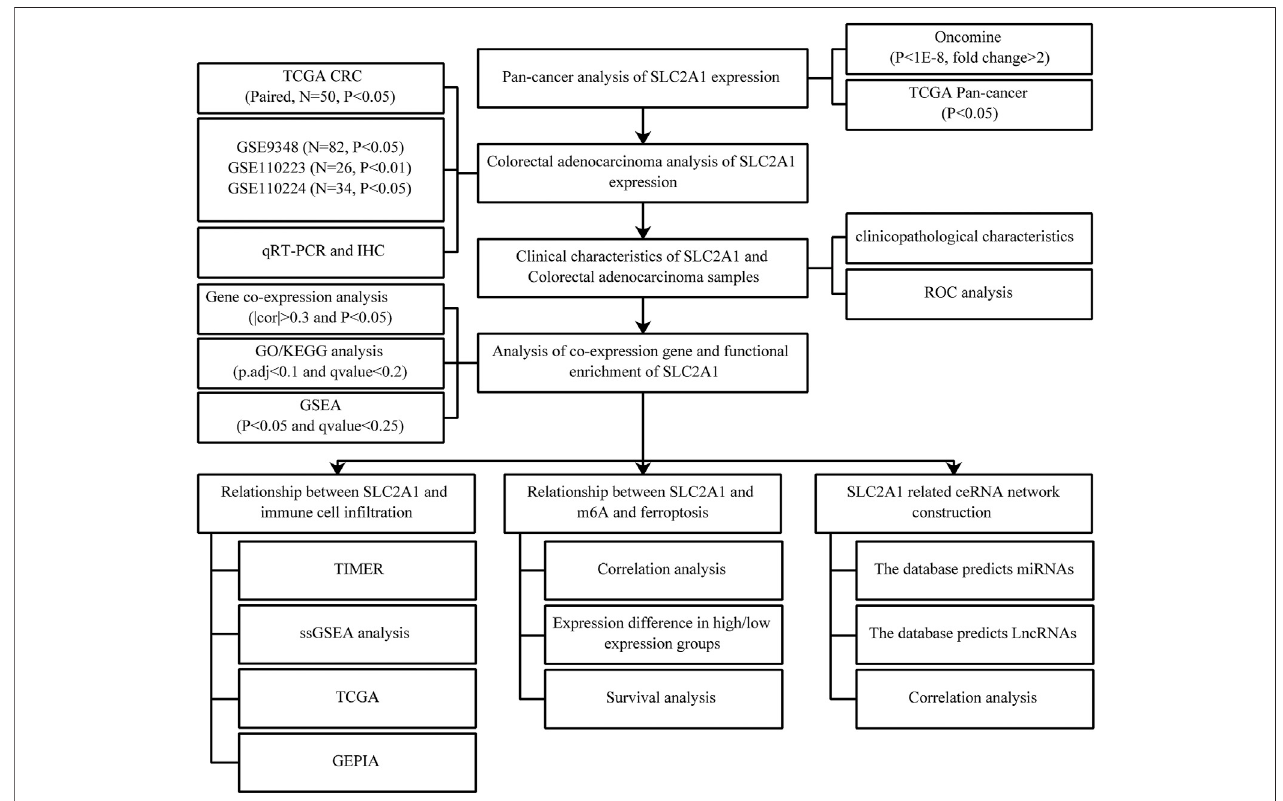
FIGURE 1 | Schematic diagram of the study